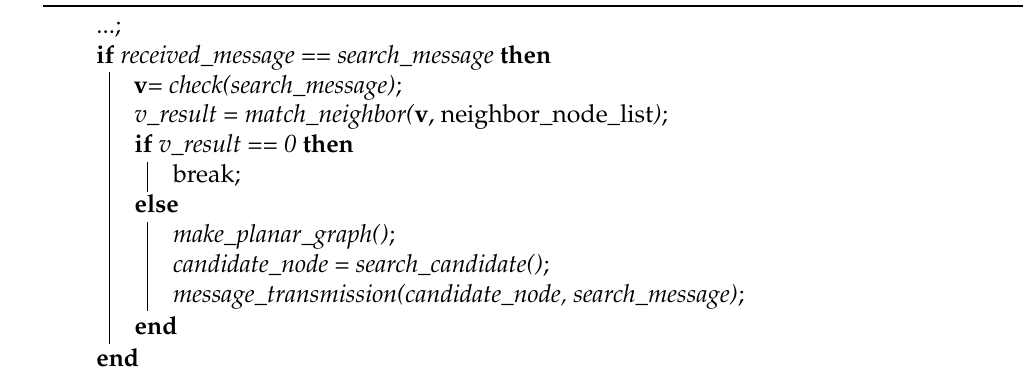
Algorithm 2: Received neighbor operation